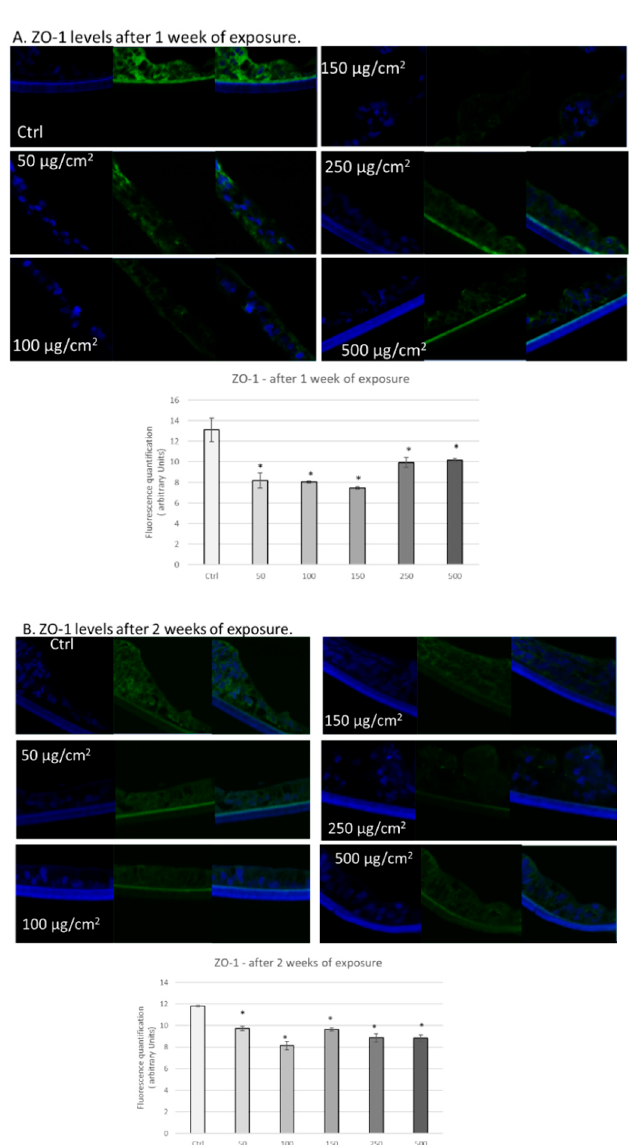
Figure 3 . Exposure to particulate matter decreased levels of ZO − 1 after 1 week and 2 weeks of exposure. Representative immunofluorescence images of levels of ZO − 1 (green color) in 3D intestinal tissues after one week (A) or two weeks (B) of exposure with the following doses of PM: 50, 100, 150, 250, and 500 µg/cm 2 . Green staining represents ZO-1. Blue staining represents DAPI. Quantification of at least three independent images taken of stained tissues from two independent experiments is represented in graphs A and B. Data are expressed as arbitrary units (averages ± SEM of two experiments, * p <